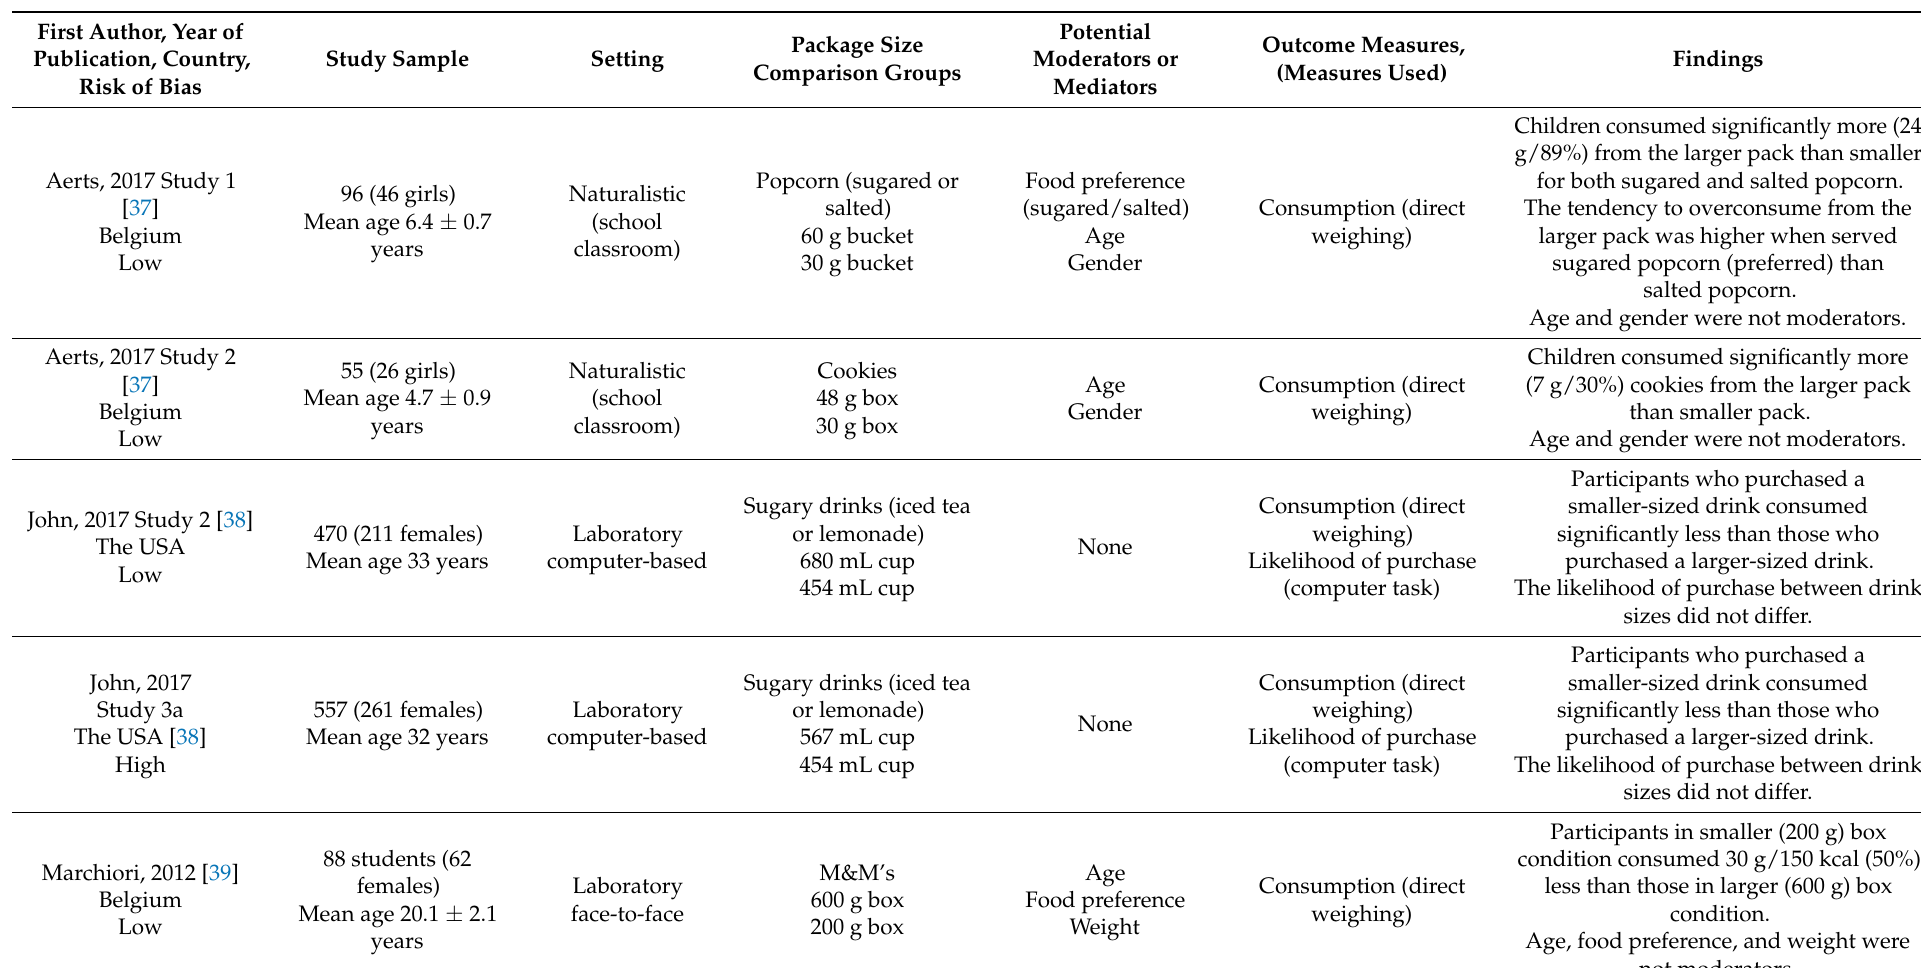
Table 2. Summary of intervention studies comparing a smaller versus larger single pack containing different total serving size of energy-dense, nutrient-poor snack and